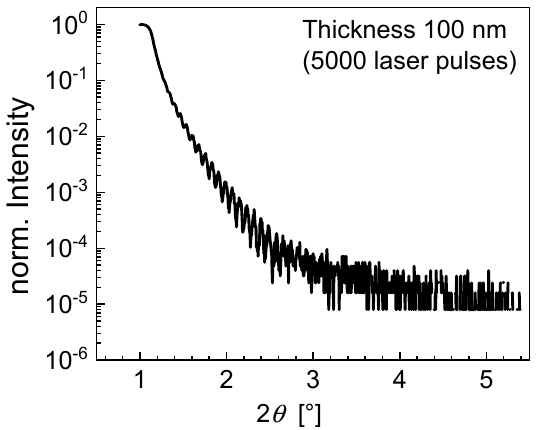
Figure 5. Reflectivity measurement with Kiessig oscillations for a PFN layer deposited with 5000 laser pulses.